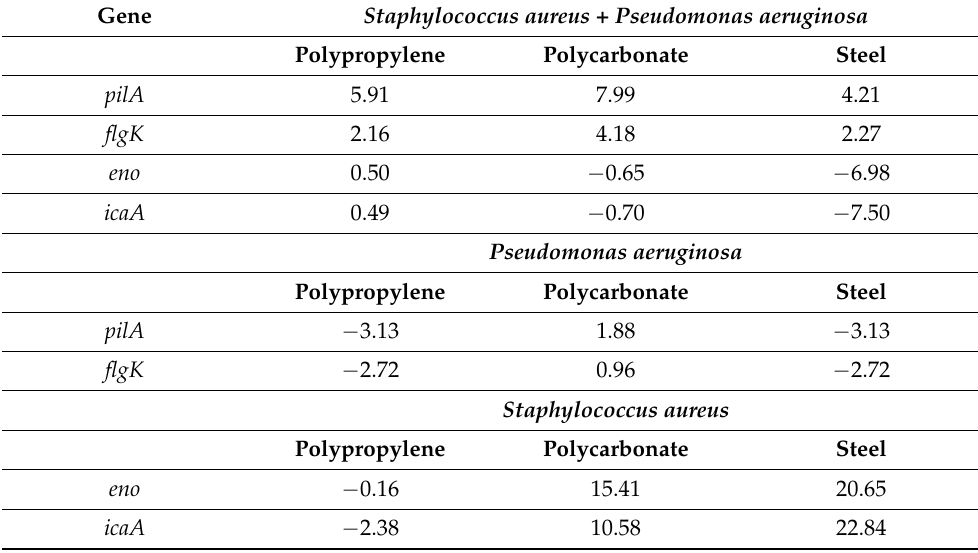
Figure 2. Comparison of limonene eradication on mono- and polymicrobial mature biofilms (( A ), S. aureus biofilm; ( B ), P. aeruginosa biofilm; ( C ), S. aureus / P. aeruginosa biofilm) grown in dynamic conditions in a CDC reactor on different materials (polypropylene, polycarbonate, and steel). Testing performed in triplicate. Error bars represent standard deviation. Statistical analysis was by two-way analysis of variance (ANOVA) with Tuckey’s multi-comparation test (** p value < 0.01, *** p value < 0.001). Table 3. Data of expression levels in S. aureus and P. aeruginosa biofilms individually and in combi- nation, exposed to limonene at sub-MIC concentrations using polypropylene, polycarbonate, and steel coupons as substrate, were reported as a fold difference (in green down-expressed genes) from control (represented by biofilm untreated) after 48 h. Fold differences greater than ± 1.5 were considered